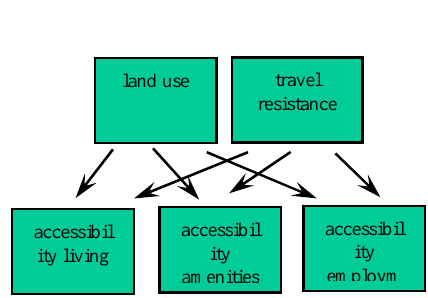
Figure 7. Aaccessibility